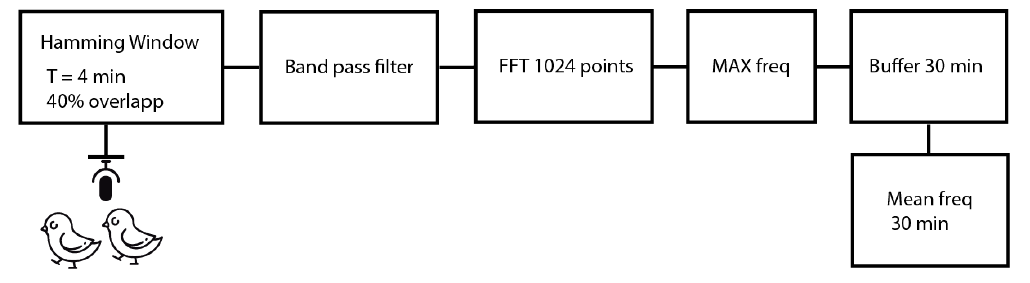
Figure 4. Peak frequency detection algorithm implementation.